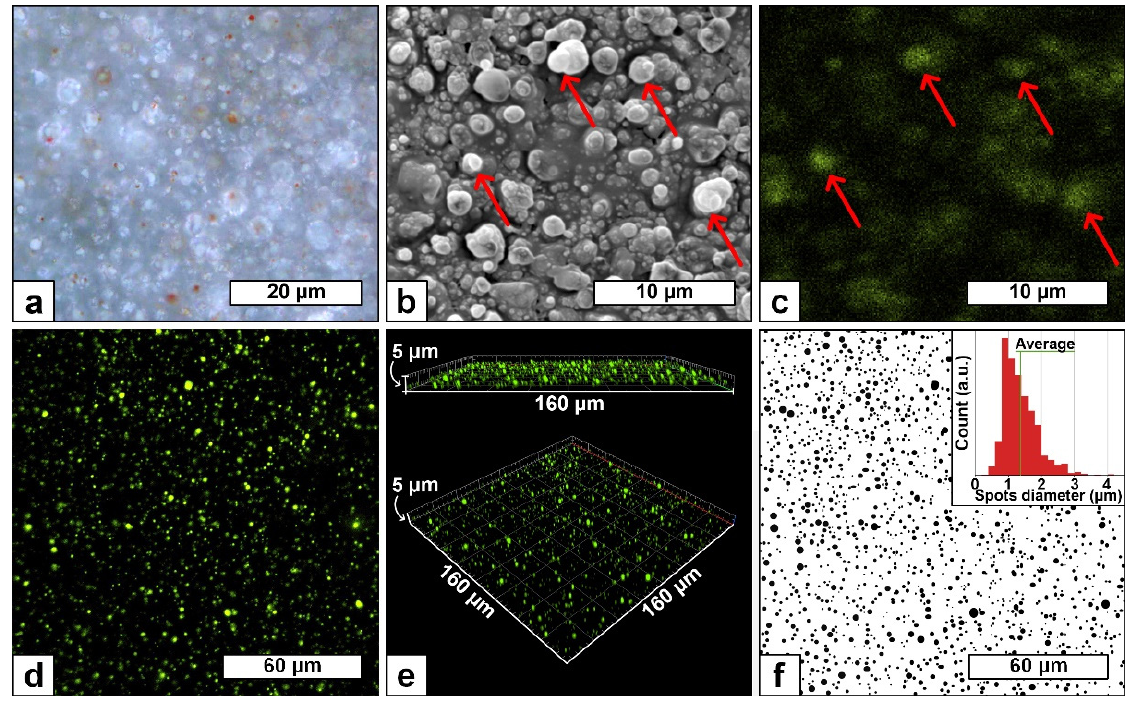
Figure 3. Characterization of different agents in coatings deposited with condition C (Water aerosol flow rate of 50 µL/min and deposition time of 5 min); bright field optical microscopy image (×100) of coating deposited with water loaded with 1 drop/mL of red colorant ( a ), scanning electron microscopy image of the surface morphology (×5000) ( b ) and corresponding energy-dispersive X-ray spectroscopy mapping of Cu ( c ) of coating deposited with water loaded with 1 mol/L of CuSO 4 , confocal microscopy image (×50, 428 nm ex /536 nm em ) ( d ) and corresponding three-dimensional representations ( e ) of coating deposited with water loaded with 0.5 mg/mL of Lucifer Yellow, LY, and binarized image of the fluorescent spots of the confocal microscopy image “d” ( f ) and extracted spots diameter distribution on 1603 spots (f, graph, top-right). When loaded with red food colorant, red spots can be visualized in the image ob- tained by optical microscopy (Figure 3a). Their presence validates that the tracer, initially